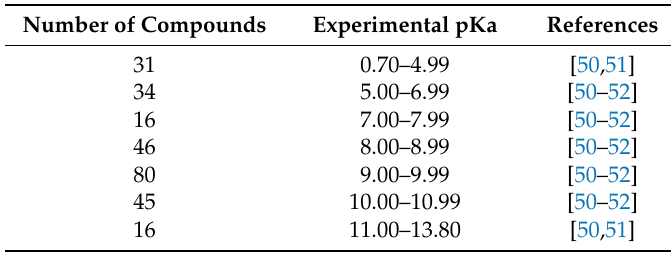
Table 1. Statistical table of experimental